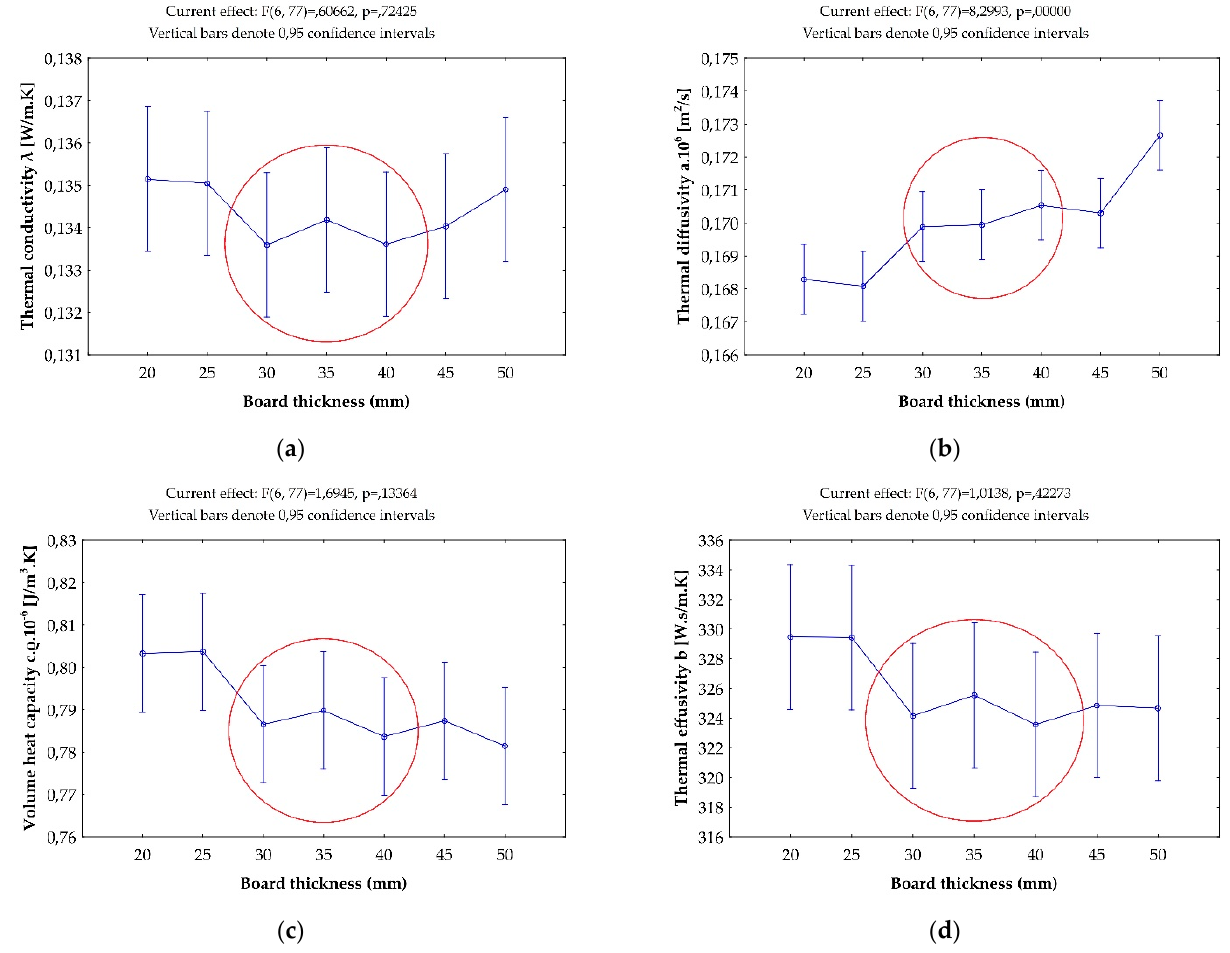
Figure 11. Graphic visualization of the effect of board (test sample) thickness on ( a ) thermal conductivity, ( b ) thermal diffusivity, ( c ) volume heat capacity, and ( d ) thermal effusivity. The monitored area is in the red oval.